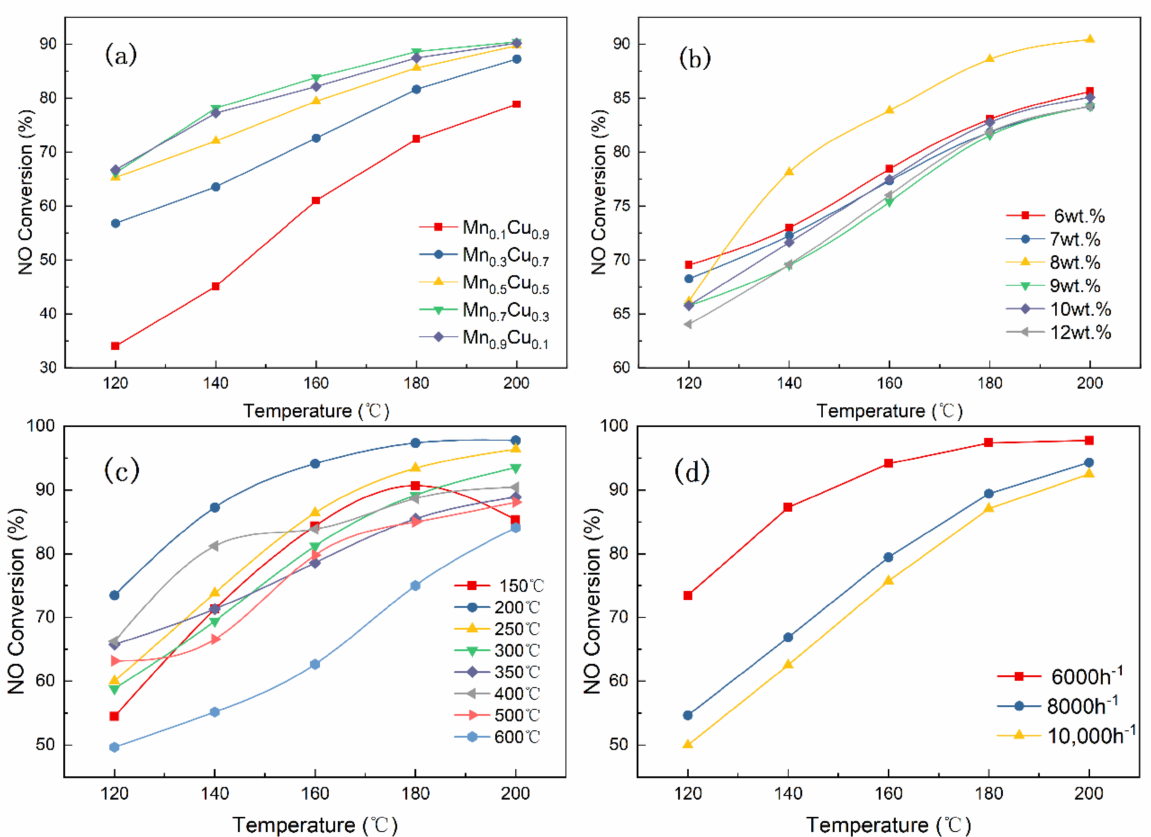
Figure 2. Catalyst activity of ( a ) different molar ratios, ( b ) different mass fraction, ( c ) different calcination temperatures, and ( d ) different space velocities (reaction conditions: NO = NH 3 = 530 ppm, O 2 = 6